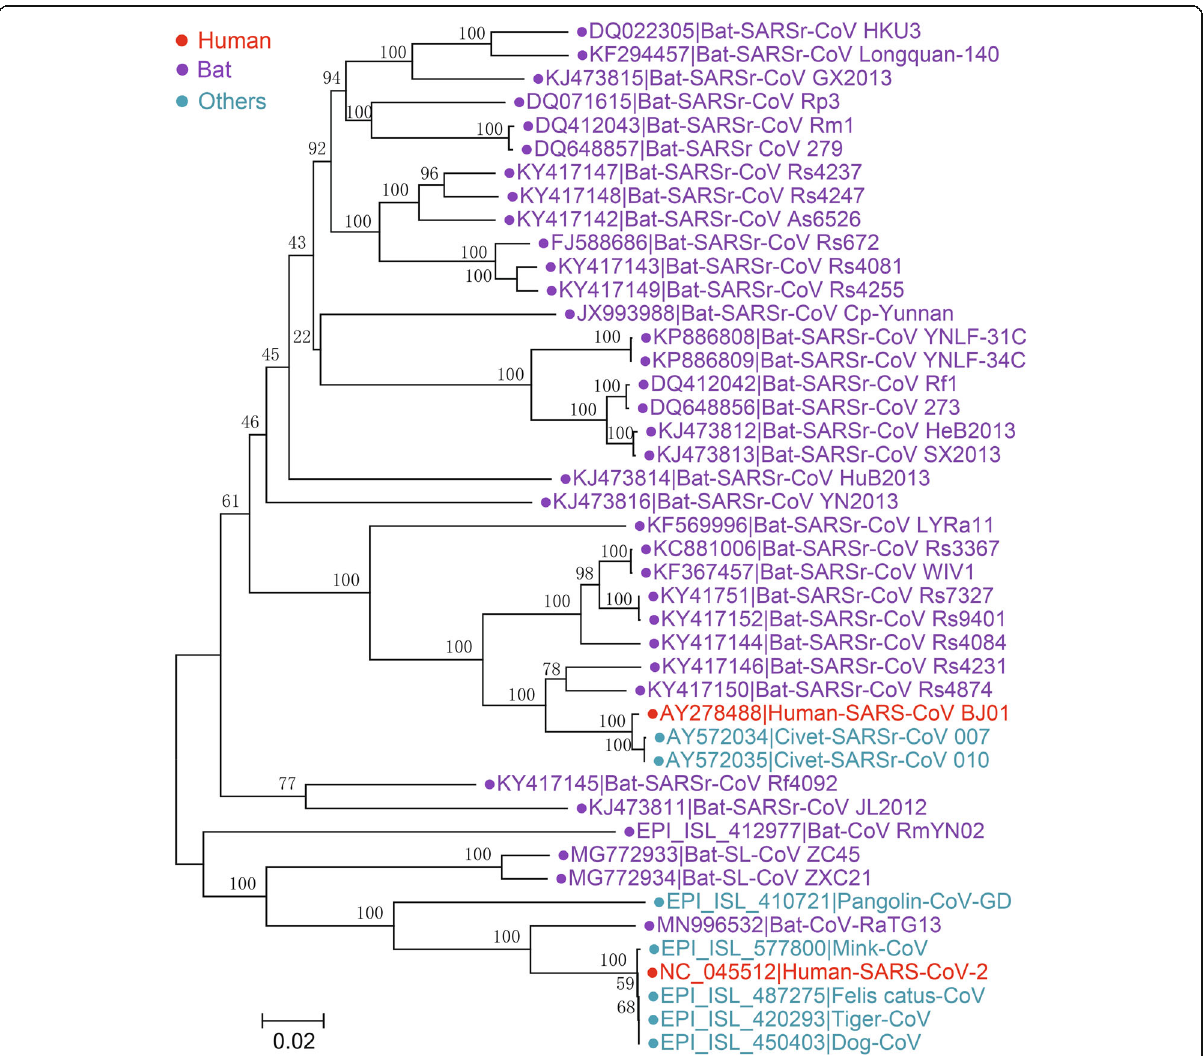
Fig. 4 The neighbor-joining tree of spike gene nucleotide sequences in Sarbecovirus . The tree was constructed using the p-distance model and 1000 bootstraps in the MEGA V. 7.0.14. Viral strains derived from humans, bats, and other animals are indicated by red, purple, and cyan,